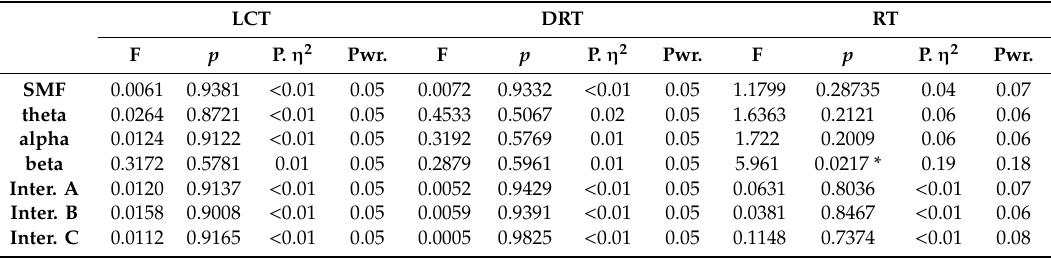
Table 2. Results of two-way analysis of variance (ANOVA) with repeated-measurement design of score from lane change task (LCT), driving reaction time (DRT) and reaction time (RT) tests for static magnetic field (SMF) exposure, the average PSD values of theta, alpha and beta sub-bands, and the Inter. A (interaction of SMF exposure x theta), Inter. B (interaction of SMF exposure x alpha) and Inter. C (interaction of SMF exposure x beta) in three tests. LCT DRT